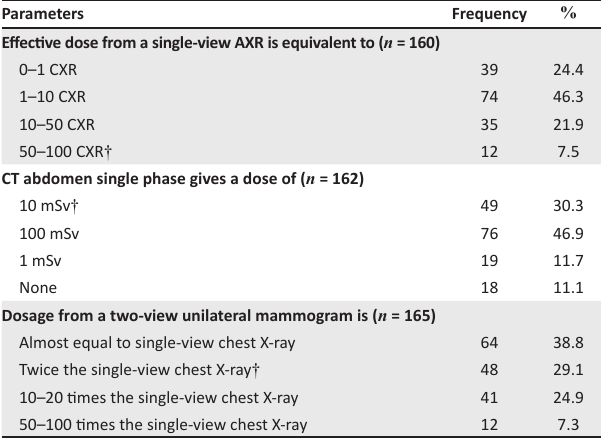
TABLE 2: Doctors’ awareness of diagnostic radiation doses.